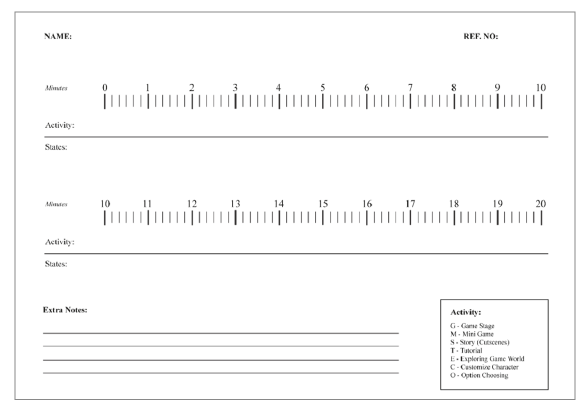
Figure 2: Event coding scheme. The event coding scheme can aid theresearchertorecordtheparticipants’activityandtheiremotional and behaviour responses.